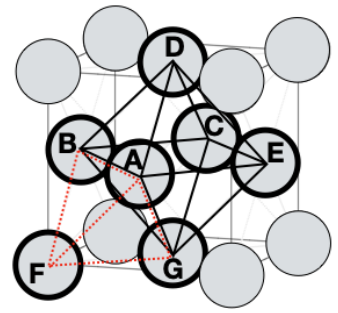
Figure 5. Tetrahedron and octahedron clusters on the FCC cell. Letters denote atomic sites and correspond to the third column of Table